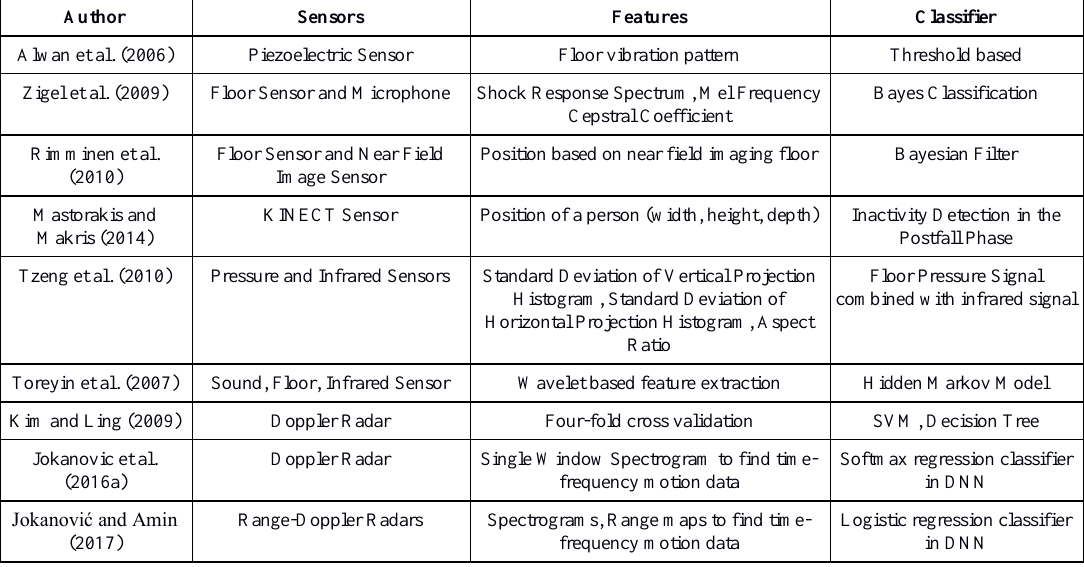
Table 2. Ambient-based Fall Detection